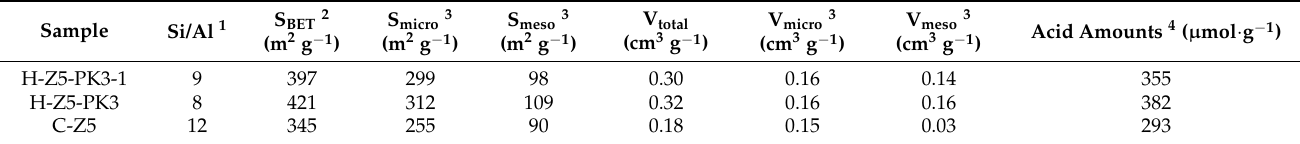
Table 1. Elemental analyses, textural parameters, and acid amounts of the different ZSM-5 samples.